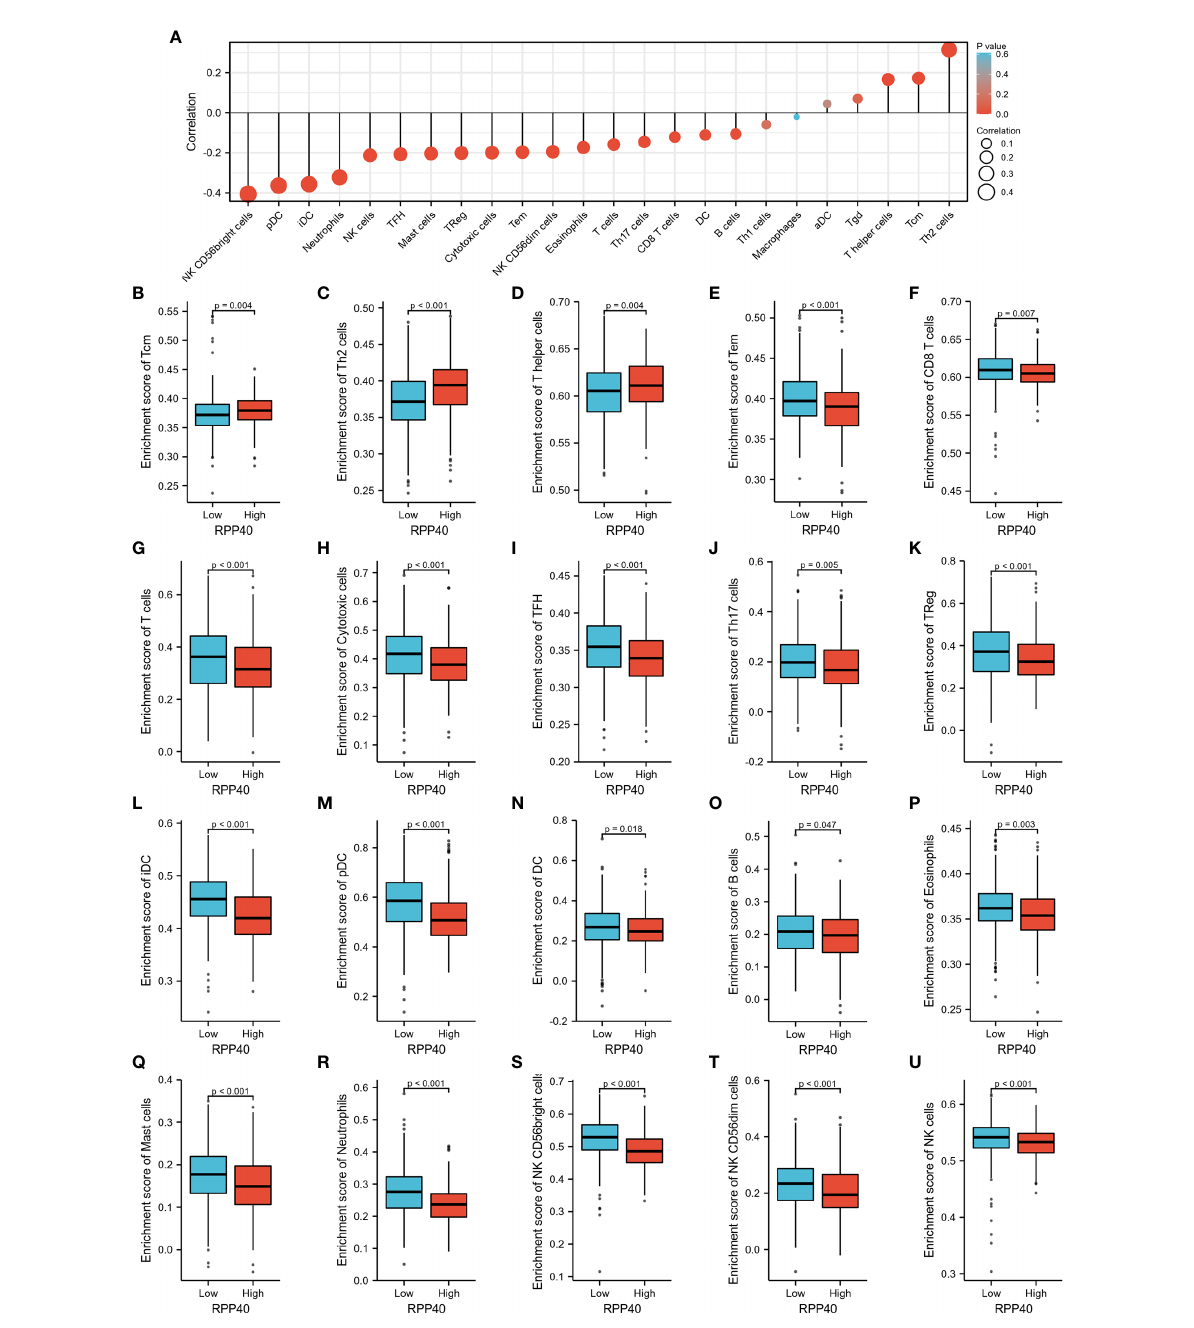
FIGURE 9 Relationships between RPP40 expression and immune cell in fi ltration in UCEC tumors. (A) The correlation of immune cell in fi ltration levels (24 cell types) and RPP40 mRNA expression was evaluated by Spearman ’ s analysis. (B – U) The comparison of the in fi ltration levels of signi fi cantly correlated immune cells, including Tcm (B) , Th2 cells (C) , T helper cells (D) , Tem (E) , CD8 T cells (F) , T cells (G) , cytotoxic cells (H) , TFH (I) , Th17 cells (J) , Treg (K) , iDC (L) , pDC (M) , DC (N) , B cells (O) , eosinophils (P) , mast cells (Q) , neutrophils (R) , NK CD56bright cells (S) , NK CD56dim cells (T) , and NK cells (U) between high- and low-RPP40-expression groups of UCEC